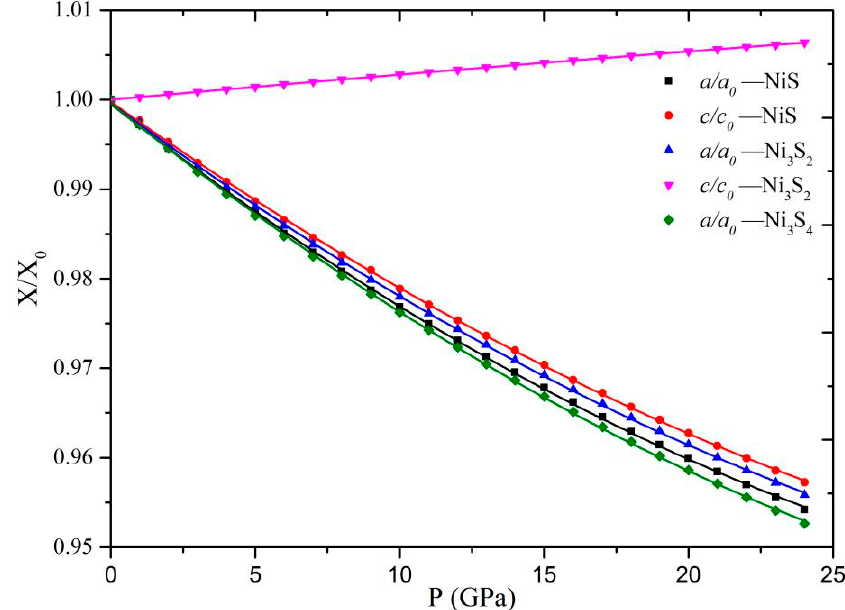
Figure 1. Pressure dependence of structure parameters for millerite, heazlewoodite, and polydymite.